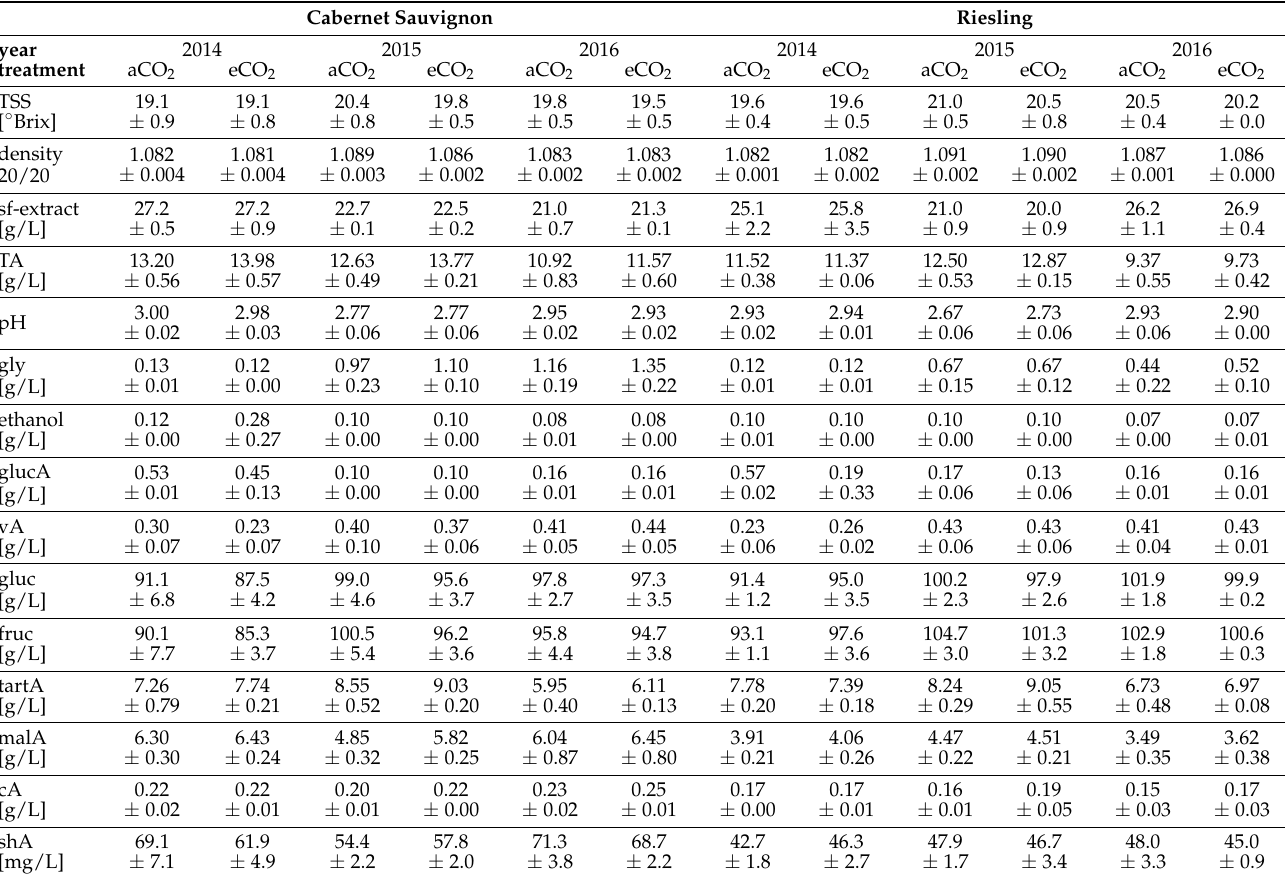
Table 2. Parameters of Cabernet Sauvignon and Riesling must analysis at two CO 2 levels (aCO 2 and eCO 2 ) at harvest date in 2014, 2015 and